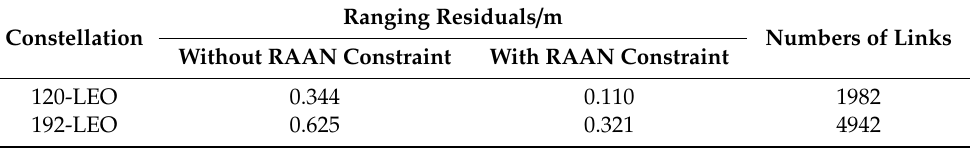
Remote Sens. 2019 , 11 , x FOR PEER REVIEW Table 4. Average link ranging residuals and total numbers of links of 120- and 192-LEO constellation. Ranging Residuals / m Constellation Numbers of Links Without RAAN Constraint With RAAN Constraint